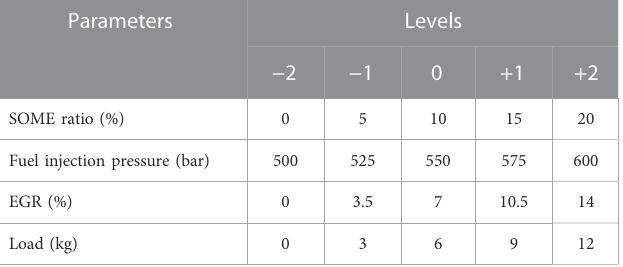
TABLE 5 The input variables with their levels. Parameters